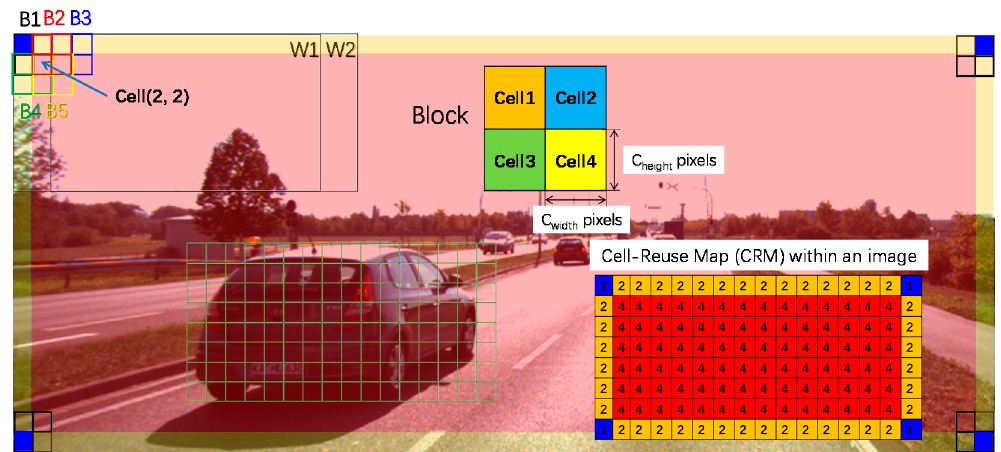
Figure 2. Illustration of the Cell-Reuse map based on the 128 × 64 DW and 2 × 2 cell blocks within an image.